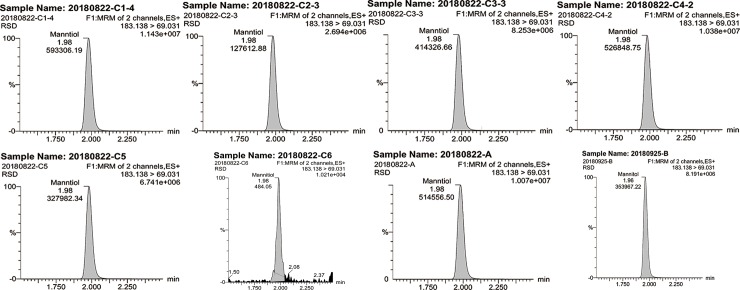
Mannitol contents in different samples.